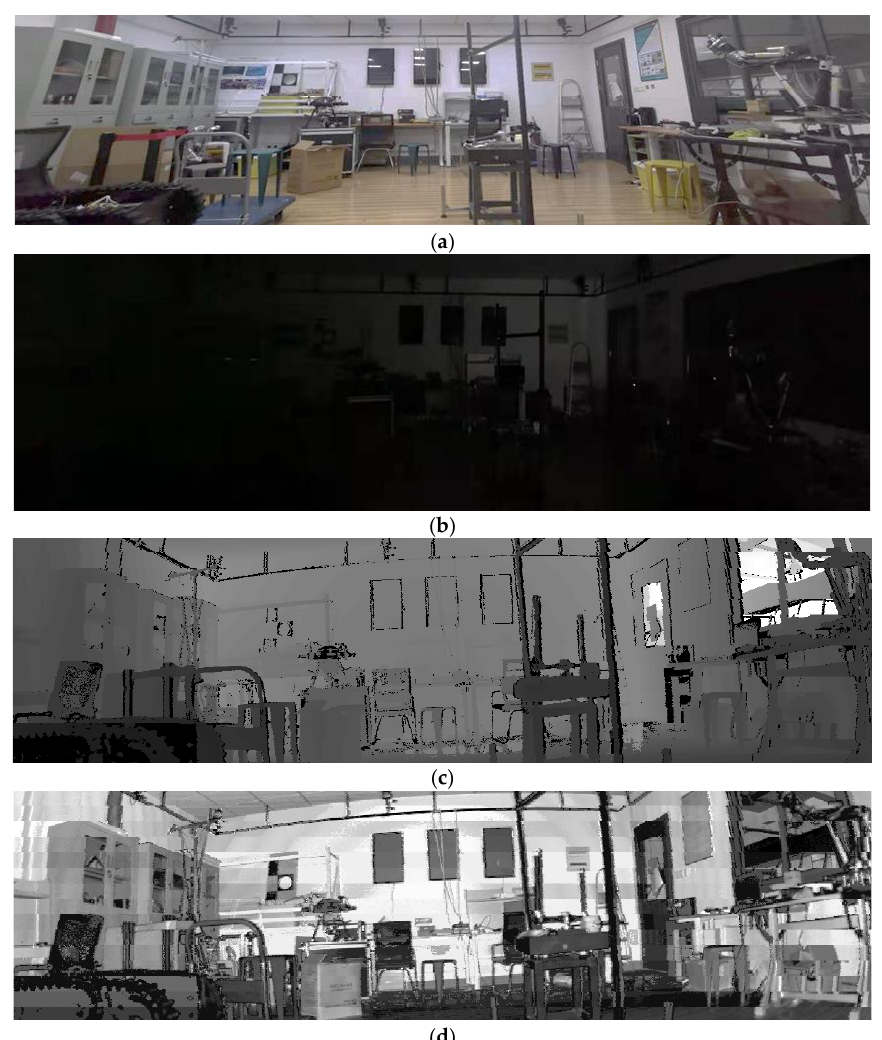
Figure 12. Camera and LiDAR image comparison in an indoor scene: ( a ) the image by a camera under normal lighting conditions; ( b ) the image by a camera under very weak lighting conditions; ( c ) the RV Image by our dense scanning system under very weak lighting conditions; ( d ) the ReV. Image by our dense scanning system under very weak lighting conditions.